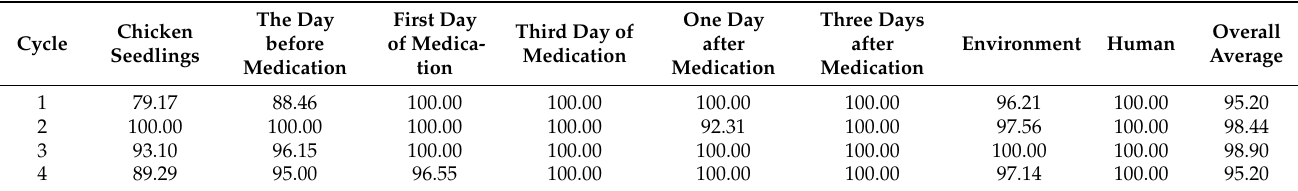
Table 3. Resistance rate of E. coli isolated in four breeding cycles to enrofloxacin (unit: %). Chicken Cycle